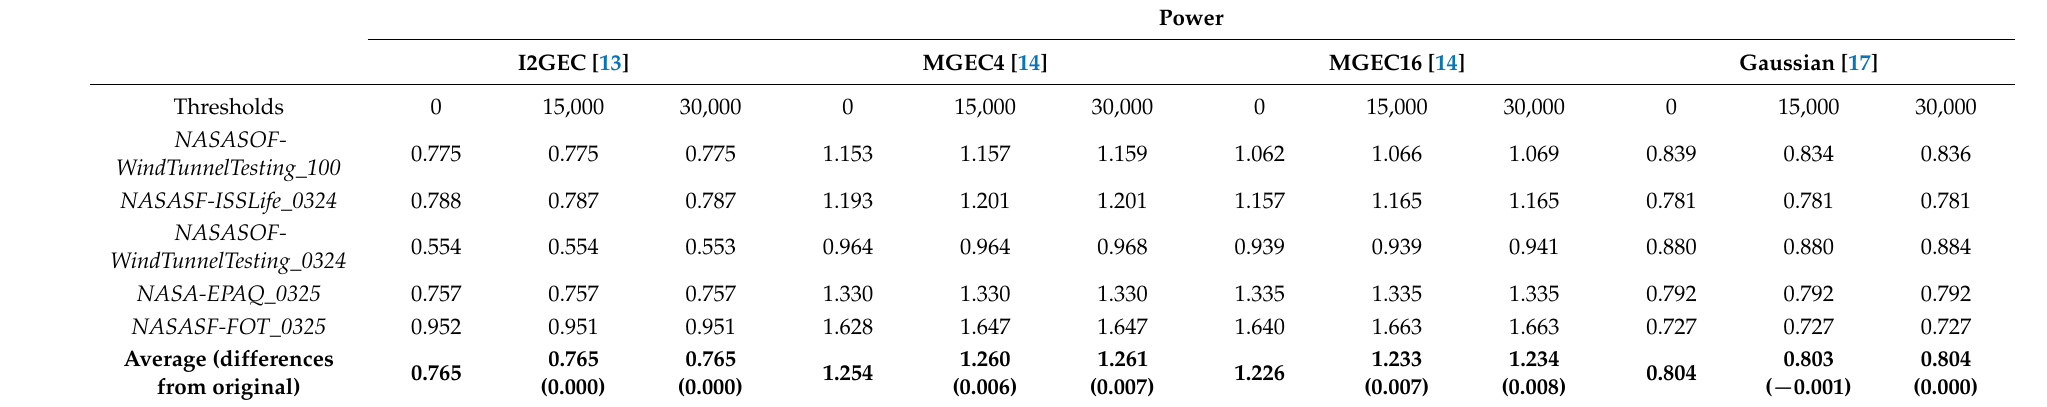
Table A3. Power (watts; to the third decimal place) of different algorithms at different thresholds.